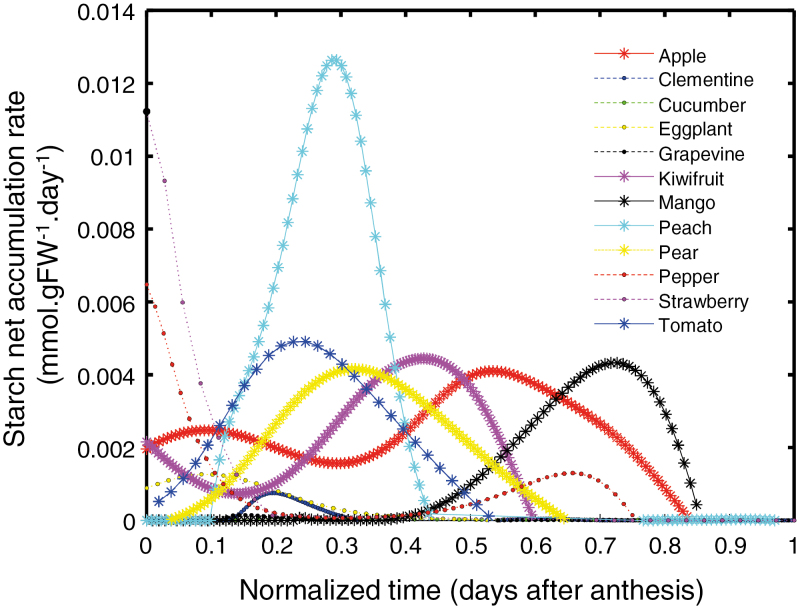
Starch net accumulation rates in 12 fleshy fruit species. Rates (expressed in mmol g–1 FW day–1 of glucose equivalent) were calculated from the fit of starch accumulation and fruit growth. Additional datasets were collected for tomato (Biais et al., 2014), strawberry (Cakpo et al., 2020), mango (Tandon and Kalra, 1983), and pear (Oikawa et al., 2015) fruits. Time is normalized against total time from anthesis to ripeness. Climacteric species are indicated with asterisks and solid lines.